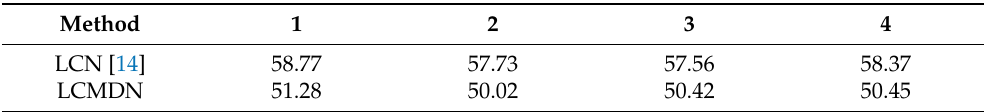
Table 3. Comparison between different steps of neighbors. The numbers in the first row represent the value of K